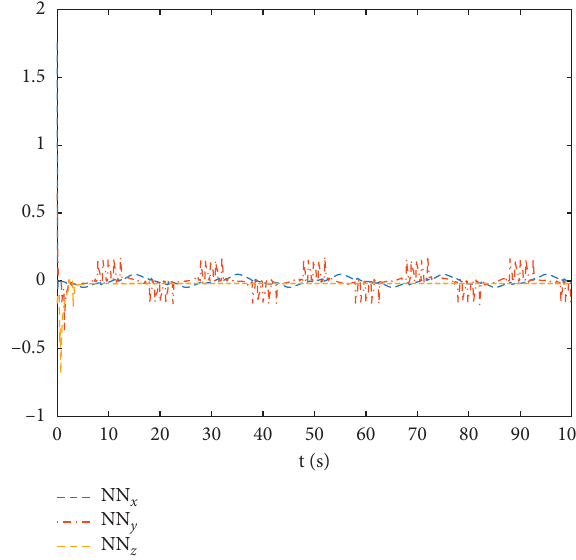
e . d , and error θ